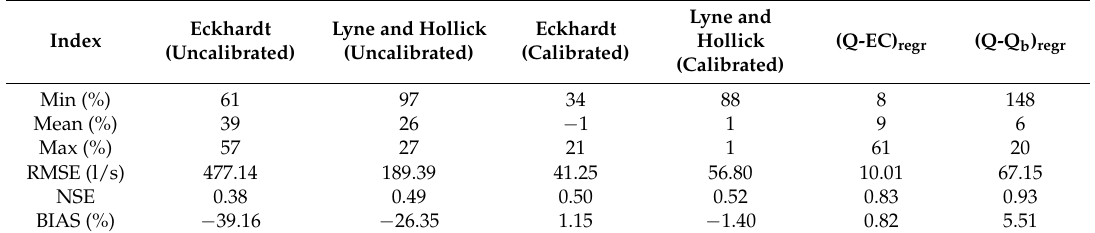
Table 2. Baseflow statistics percentage errors (Min, Mean and Max) and goodness-of-fit indices for the different adopted filters (errors are with regard to the MBF